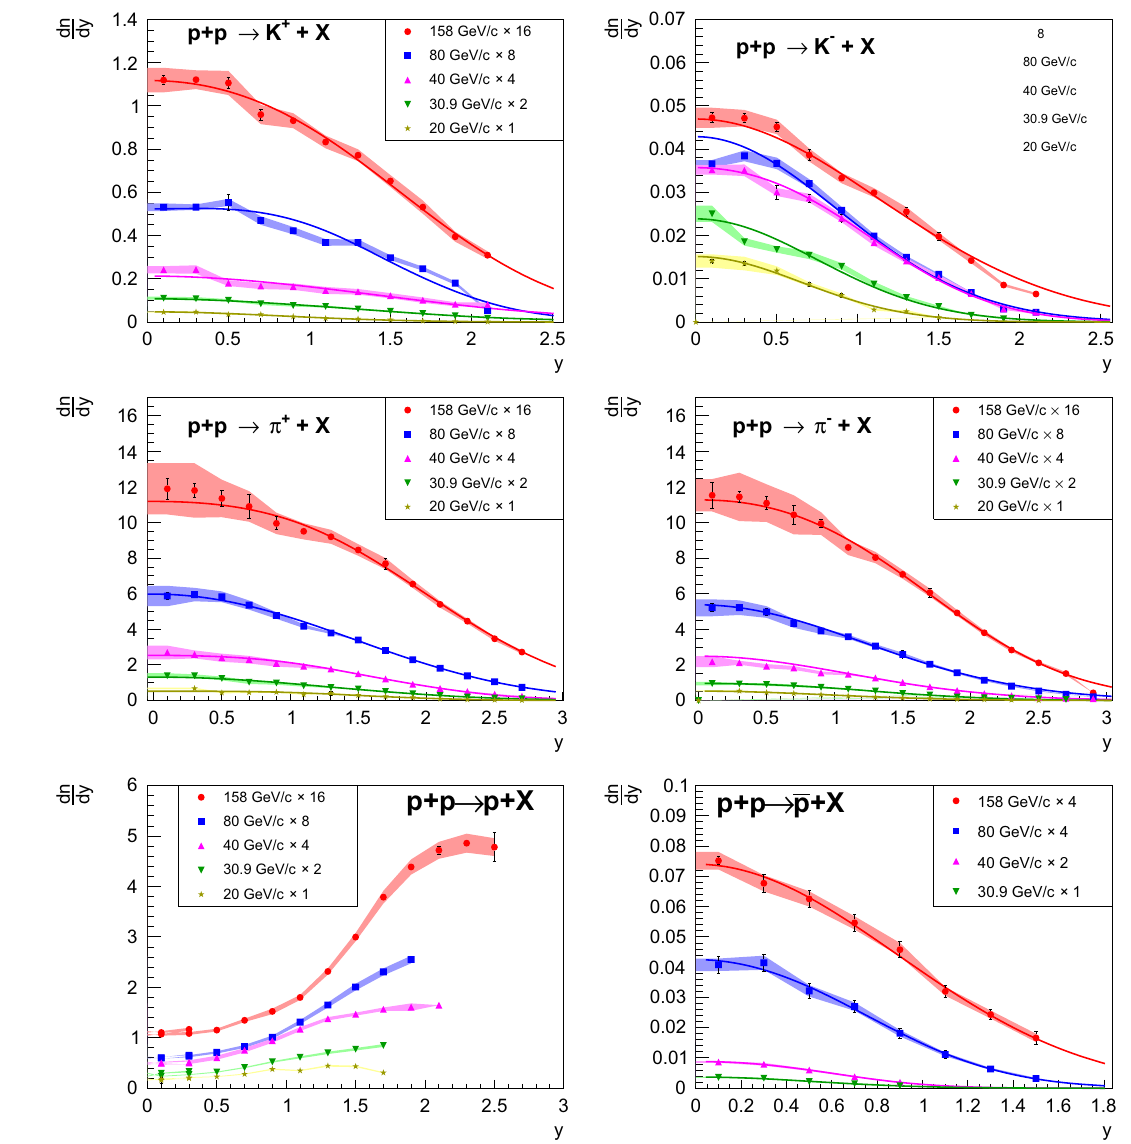
Fig. 34 Rapidity spectra of K + , K − , π + , π − , p and ¯ p pro- duced in inelastic p + p interactions at SPS energies, scaled by appropriate factors for better visibility. Vertical bars indi-